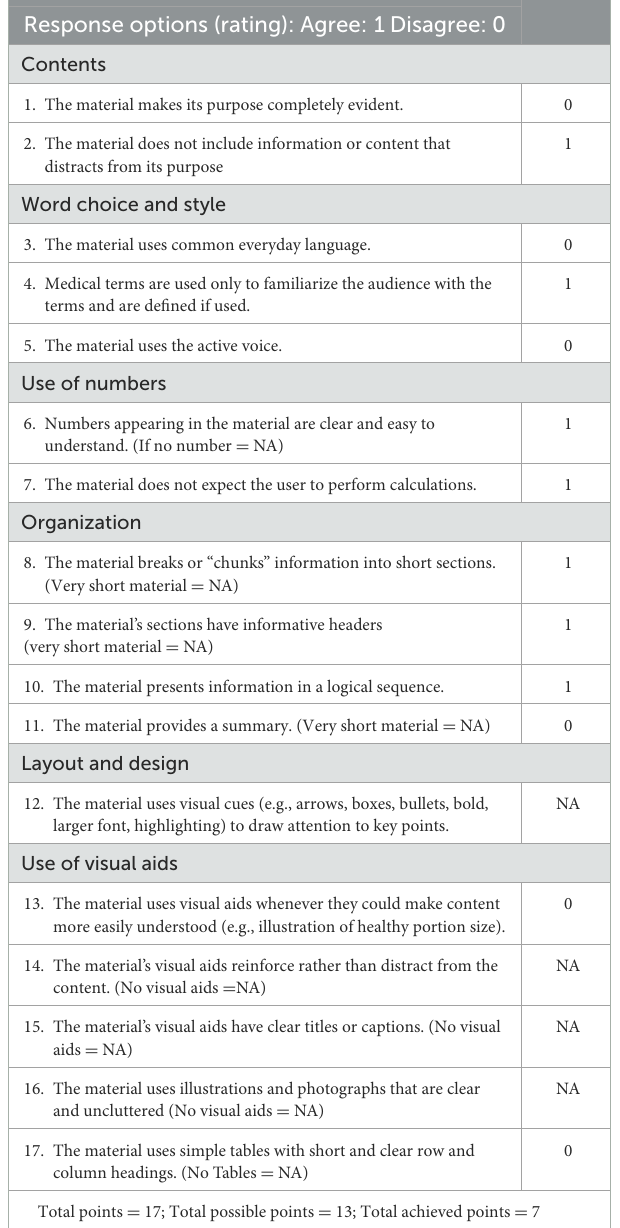
TABLE 1A Assessment of printed patient education materials provided to caregivers in CSPM (using PEMAT-P): understandability. Health education